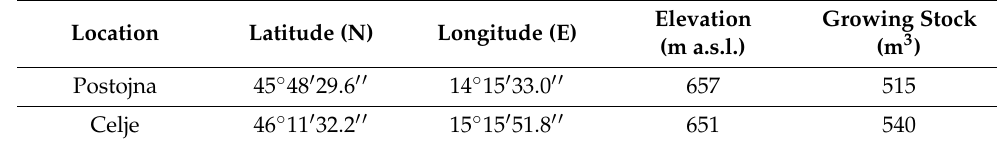
Figure 1. Research site location. Table 1. Postojna and Celje site characteristics.